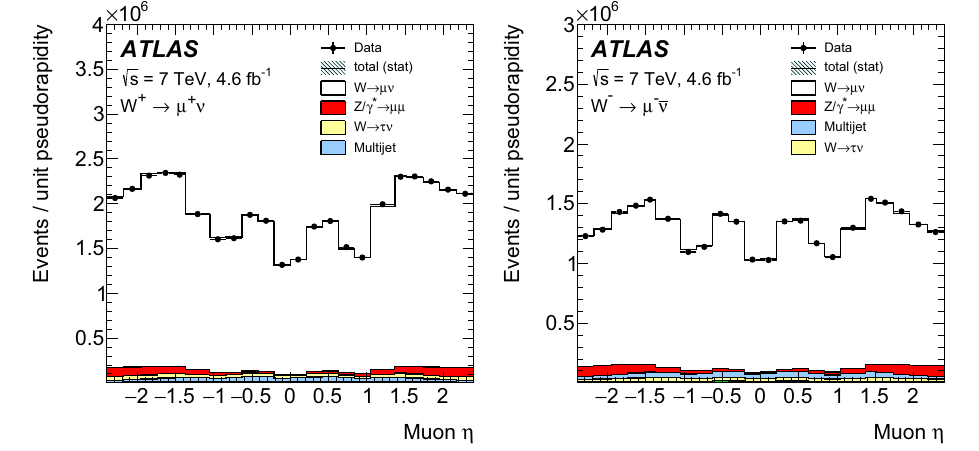
Fig. 11 The pseudorapidity distribution of muons for W + → μ + ν candidates ( left ) and W − → μ − ¯ ν candidates ( right ). The simulated samples are normalized to the data luminosity. The multijet background shape is taken from a data control sample and normalized to the esti-